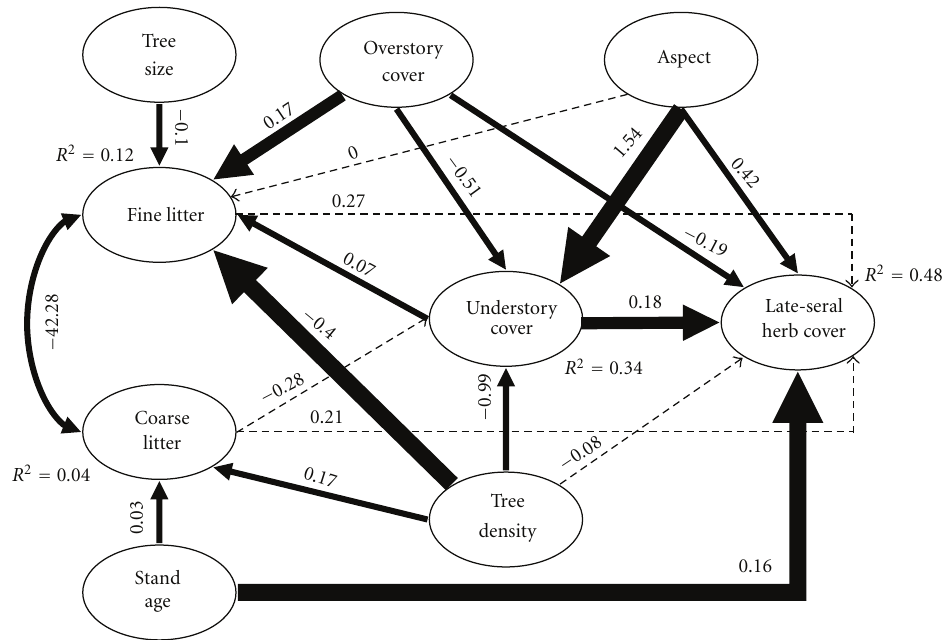
Figure 4: The fitted SR model with unstandardized parameter estimates. The observed variables and the error arrows of endogenous latent variables are omitted to simplify the diagram. Estimated unstandardized path coe ffi cients (direct e ff ects) are placed alongside each path. The squared multiple correlations ( R 2 ) are included for each endogenous latent variable. The thickness of a single arrowhead corresponds to the strength of its estimates (based on its standardized estimate). The dashed single arrowheads depict non-significant paths. The double arrowheads depict the error covariance between the errors of fine litter and coarse litter latent